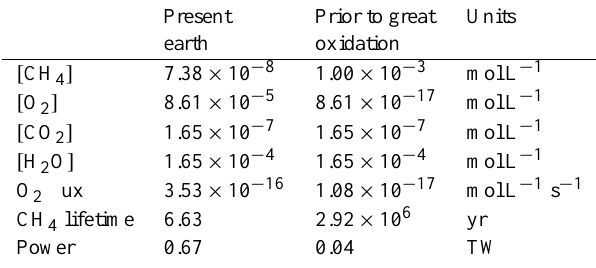
Table 2. Data used for an estimate of the lifetime of methane and its disequilibrium or present Earth conditions and before the Great Ox- idation Event, when the biosphere was dominated by methanogens. The CH 4 lifetime is calculated as the ratio of atmospheric concen- tration to flux into the atmosphere. In the case of the present atmo- sphere, the limiting flux is methane, whilst prior to the Great Oxi- dation Event the oxygen flux was likely to be much smaller than the methane flux and thus the limiting flux. Atmospheric concentrations and methane flux estimates are taken from Kharecha et al.